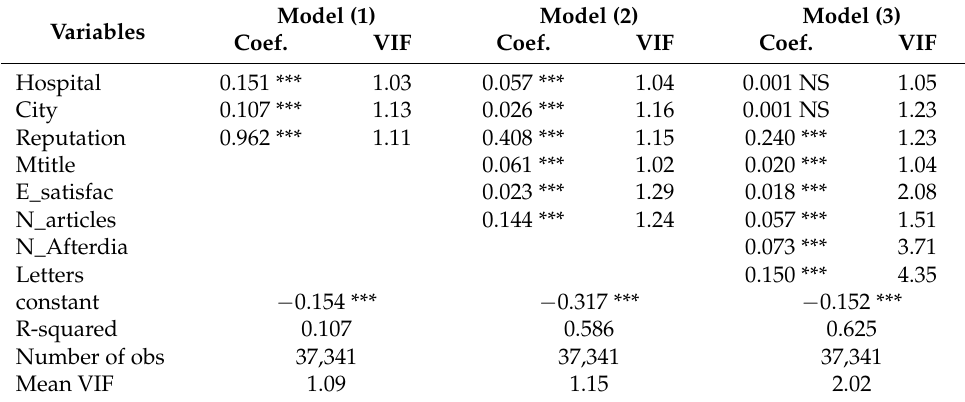
Table 4. Analysis of regression